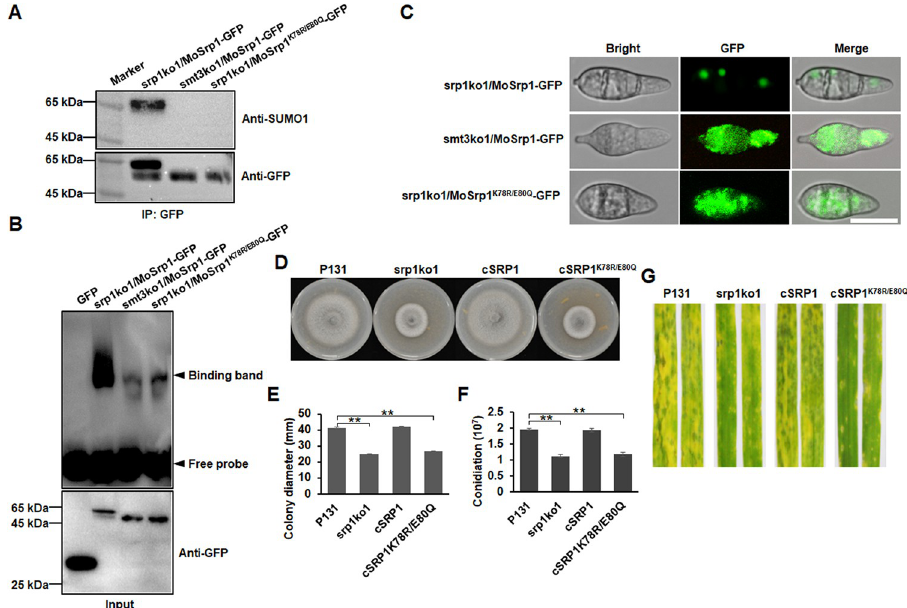
Fig 9. SUMOylation is required for MoSrp1 functions. (A) Immunoblot of the GFP-immunoprecipitated proteins from strains srp1ko1/MoSrp1-GFP, smt3ko1/MoSrp1-GFP, and srp1ko1/MoSrp1 K78R/E80Q -GFP detected with an anti- SUMO1 antibody and an anti-GFP antibody, respectively. (B) RNA-EMSA assay showing binding strength of SUMOylated MoSrp1 from strain srp1ko1/MoSrp1-GFP to the 5’-GUAG-3’ consensus and the non-SUMOylated MoSrp1 from strains smt3ko1/MoSrp1-GFP and srp1ko1/MoSrp1 K78R/E80Q -GFP (the upper panel). The proteins were detected by western blot with an anti-GFP antibody (the bottom panel). (C) The GFP signals are localized in the conidial nuclei of strain srp1ko1/MoSrp1-GFP while scattered in the cytoplasm of strains smt3ko1/MoSrp1-GFP and srp1ko1/MoSrp1 K78R/E80Q -GFP. Bar, 20 μ m. (D) Colonies formed by strains P131, srp1ko1, cSRP1, and cSRP1 K78R/ E80Q (srp1ko1/MoSrp1 K78R/E80Q ) cultured on OTA plates for 5 d. (E) Statistics on colony diameters of strains P131, srp1ko1, cSRP1, and cSRP1 K78R/E80Q . (F) Conidia produced by strains P131, srp1ko1, cSRP1, and cSRP1 K78R/E80Q . The means and standard deviations in (E and F) were calculated based on three independent experiments each with three plates measured. Asterisk marks significant difference between P131 and mutant strains using t -test (p < 0.05). (G) Representative disease lesions on the leaves of susceptible barley sprayed with conidia of strains P131, srp1ko1, cSRP1, and cSRP1 K78R/E80Q .